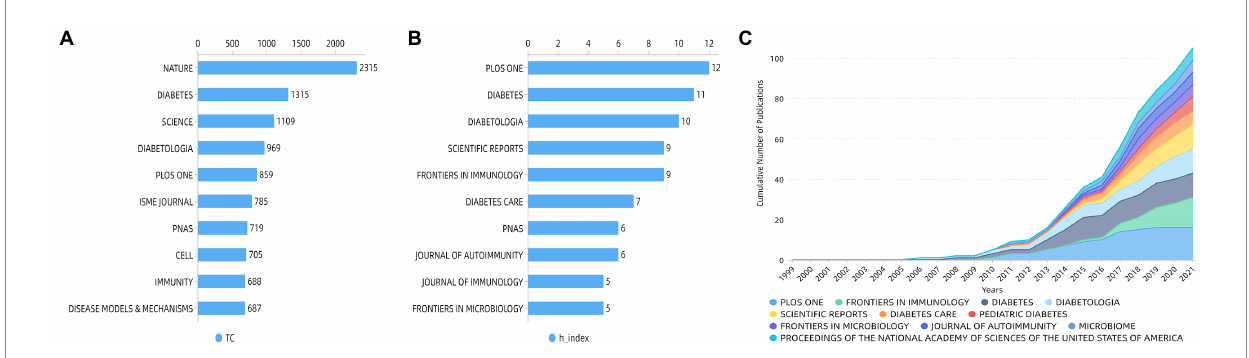
FIGURE 5 Top 10 journals by (A) total citations and by (B) h-index and (C) cumulative number of publications of the top 10